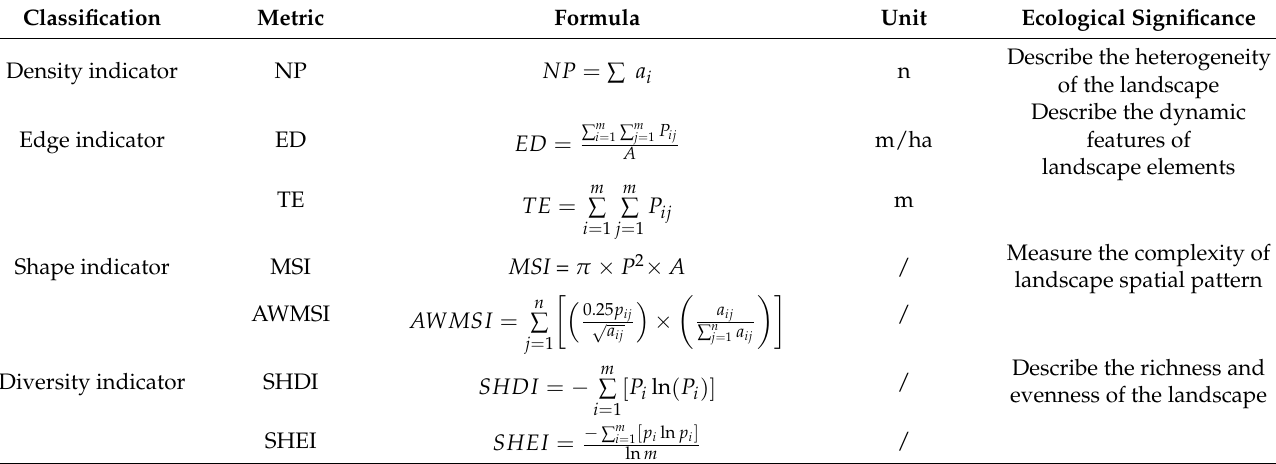
Table 3. Introduction of landscape